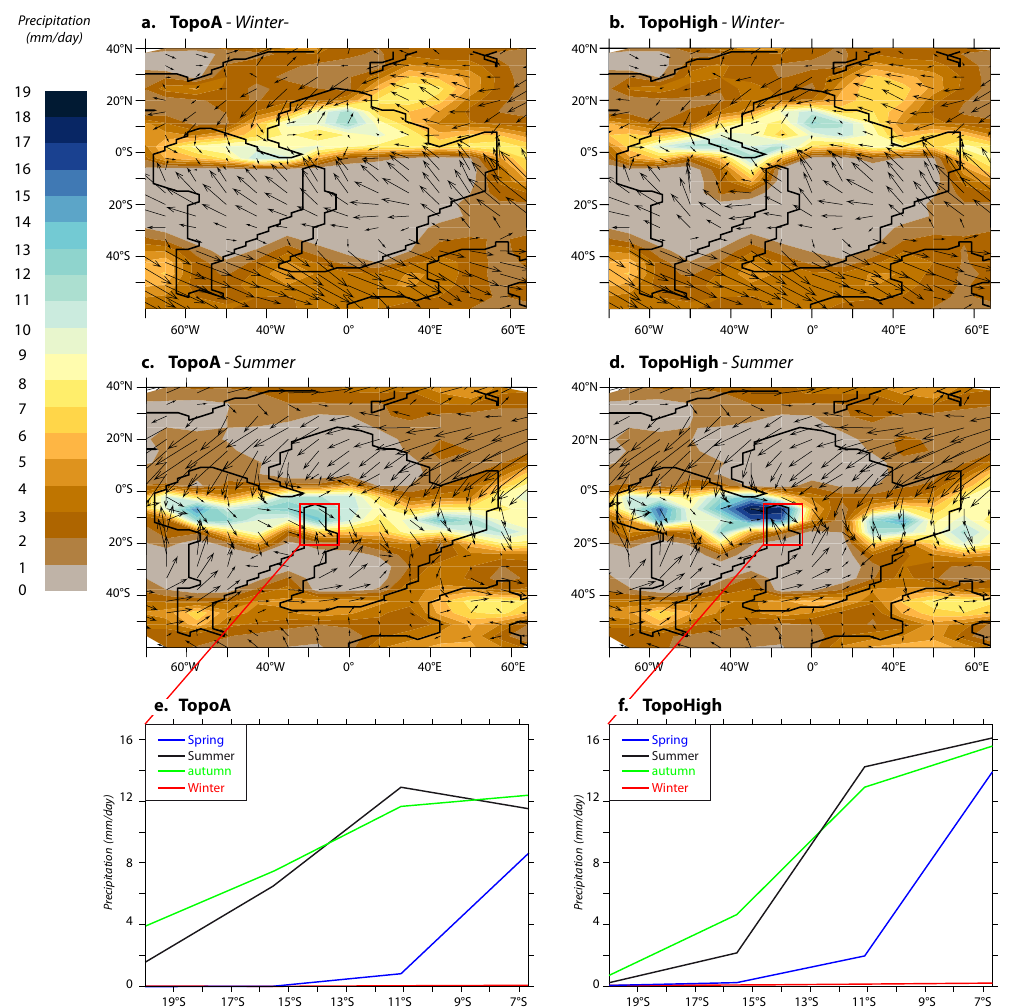
Fig. 5. Seasonal average precipitations (mmday − 1 ). (a) For the TopoA in austral winter (DJF); (b) for the TopoHigh in austral Winter; (c) for the TopoA in austral summer (JJA); (d) for the TopoHigh in austral summer. Latitudinal evolution of the seasonal average precipitation (mmday − 1 ) in the Central segment (between 5 ◦ W and 25 ◦ W) (e) for the TopoA and (f) for the